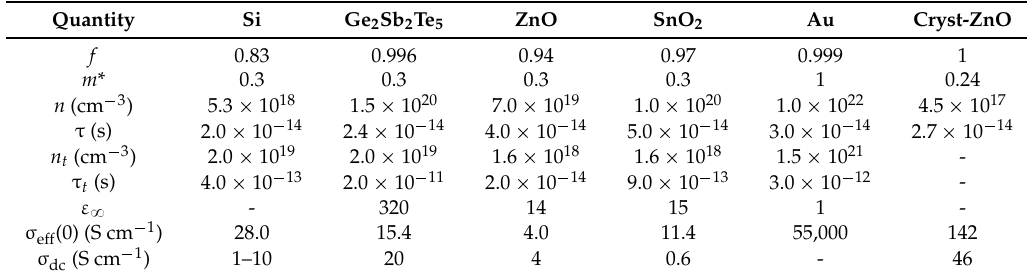
Table 1. Physical parameters used for calculation in the series sequence of the free and tunneling carrier (SSFCT) transport model. σ dc is the measured dc conductivity.